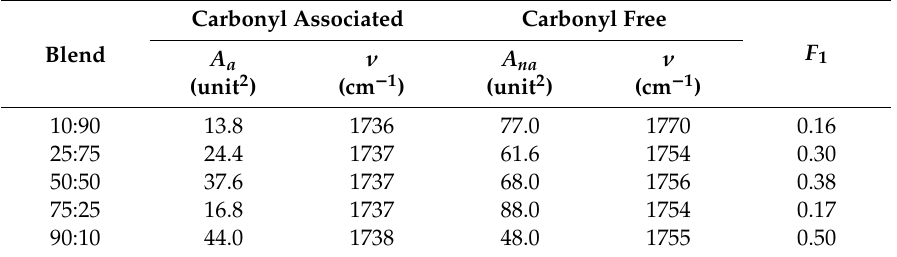
Table 1. Fractions of associated and free carbonyl bands in 1700–1800 cm − 1 in the E-VAL / PCL blends.